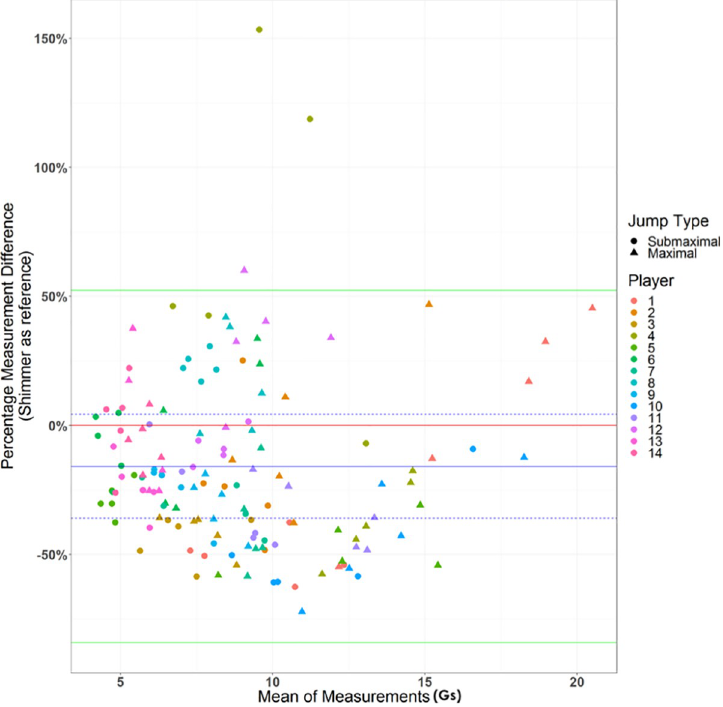
Fig 3. Bland-Altman plot for VERT and Shimmer agreement. The red line represents the 0% difference mark. The blue line represents the mean bias, or the mean percentage difference we observe between VERT and Shimmer. The dotted lines around the mean bias represent the 95% confidence interval. Lastly, the green lines represent limits of agreement, which are the (mean bias)+1.96 � (standard deviation of differences) and (mean bias)-1.96 � (standard deviation of